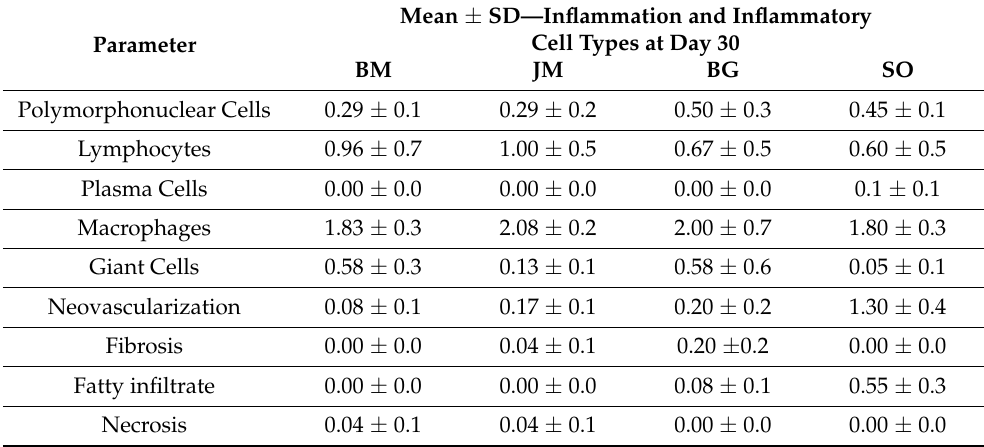
Table 5. Results of the biomaterial scoring evaluation at 30 days post implantationem. BM: bovine- based membrane, BG: Bio-Gide ® membrane, JM: Jason ® membrane, and SO: sham operation.